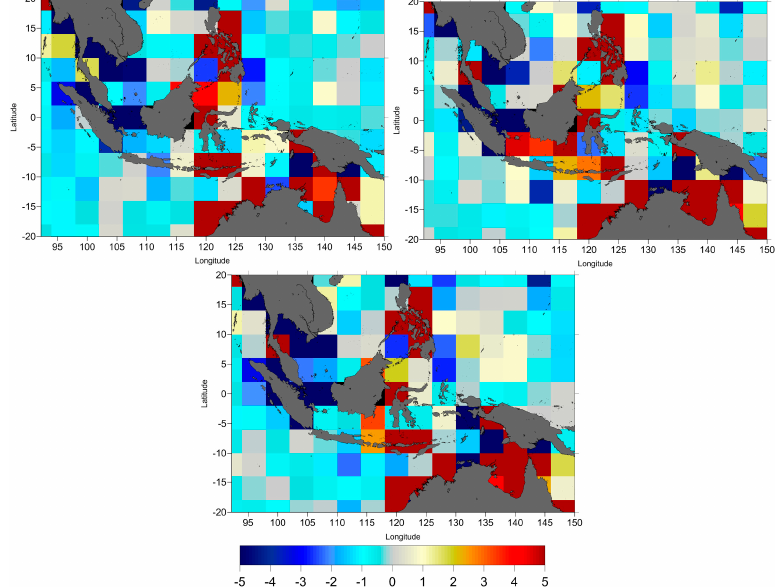
Figure 14. Along-track SLA variance differences (cm 2 ), between GOT4.10 and FES2012 tide model for TOPEX/Poseidon cycles 1–364, Jason-1 cycles 1 to 259 and Jason-2 cycles 1 to 280. Remote Sens. 2017 , 9 , 102